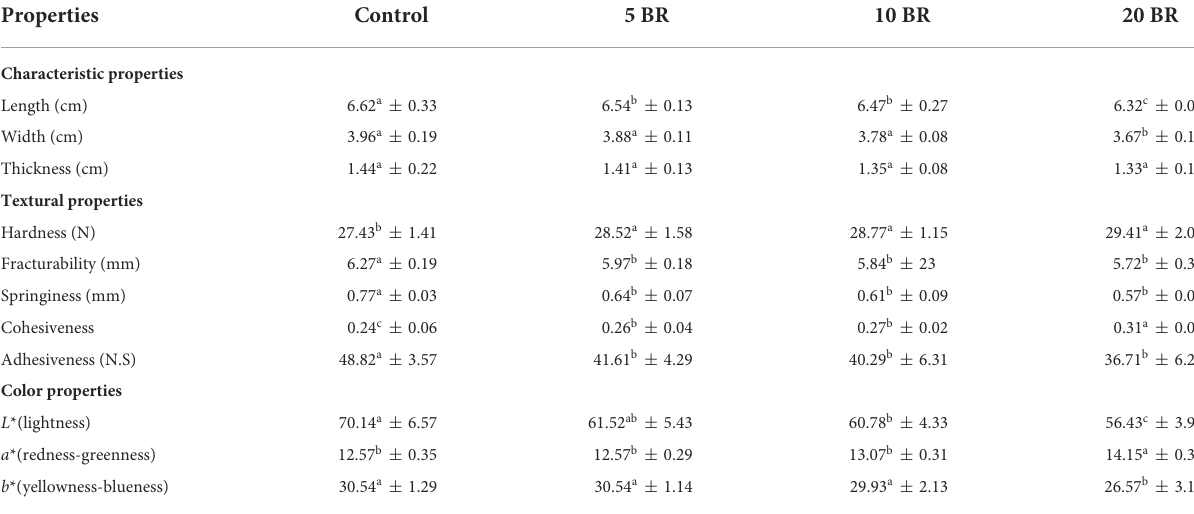
TABLE 2 Characteristics and textural properties of flaky rolls incorporated with different proportions of black rice flour.